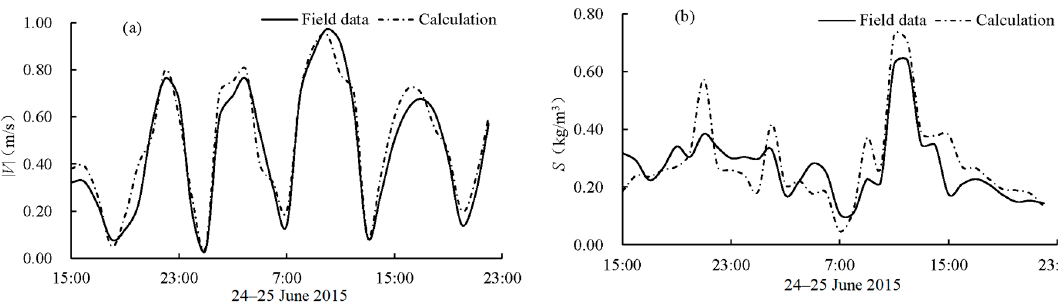
Figure 14. Model validation, numerical results vs. field data at FS4 (neap tide, June 2015): ( a ) | V | ; ( b ) S . Table 7. Error estimations of model validation (neap tide, June 2015).